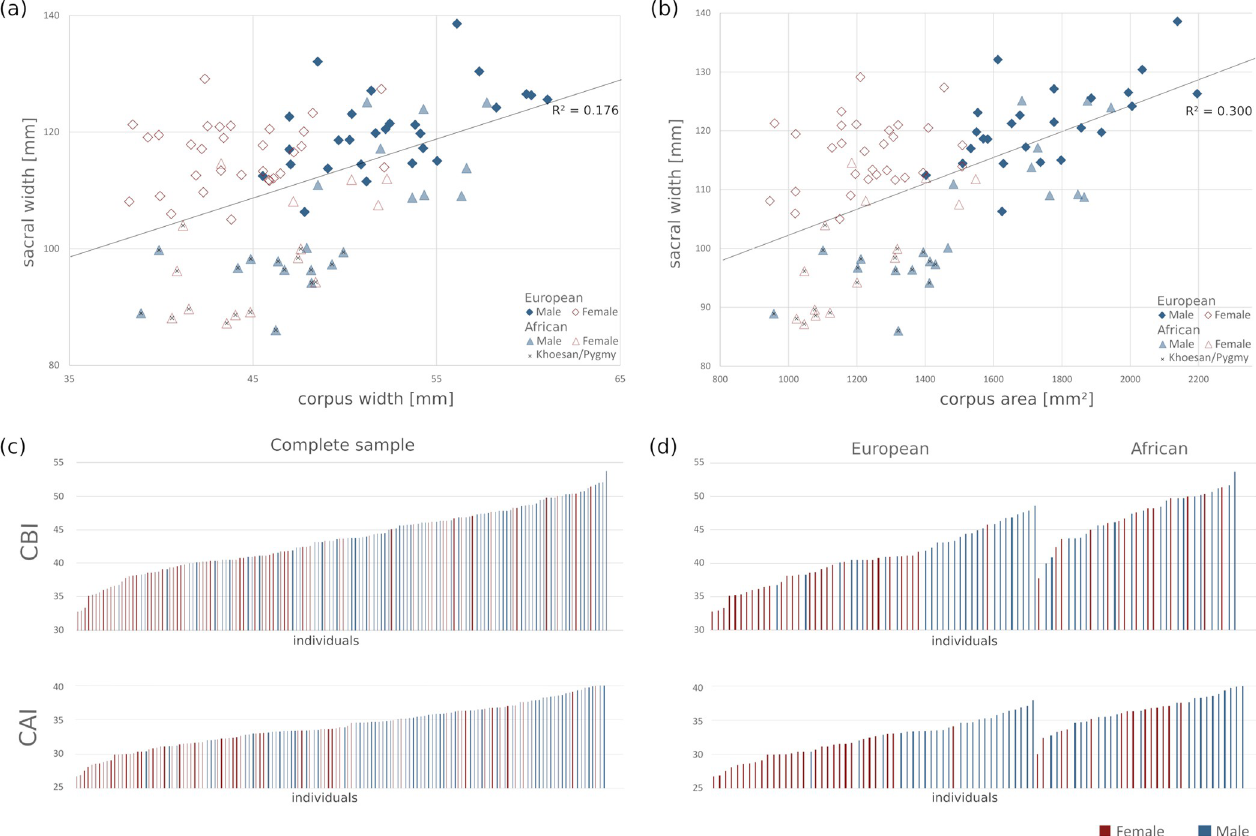
Fig 5. Variation of the linear metrics in the European and African subsets. (a) Scatterplot of sacral width (mm) and corpus width (mm); note the minimal overlap of females (red) and males (blue) in the European subset and the strong overlap in the African subset for corpus width. (b) Scatterplot of corpus depth (mm) and corpus width (mm) showing high correlation. (c) Fequency distribution of the corporo-basal index (CBI) and corpus-area index (CAI) for the complete sample. (d) Frequency distribution of the CBI and CAI for the European and the African subsamples; note the differences in the European (high discriminative power) and the African subsets (no discriminative power for CBI and moderate discriminative power for